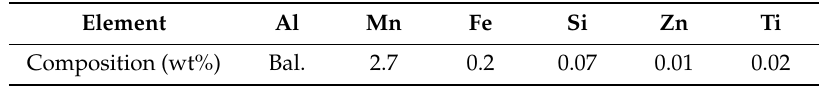
Table 1. Chemical composition of the as-cast alloy specimen analyzed by Inductively Coupled Plasma Optical Emission Spectroscopy (ICP-OES). Element